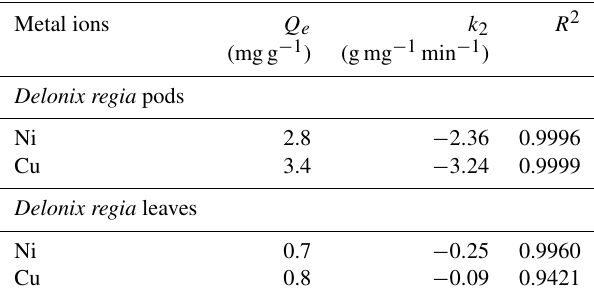
Table 1. Parameters obtained from the pseudo-second-order kinetic